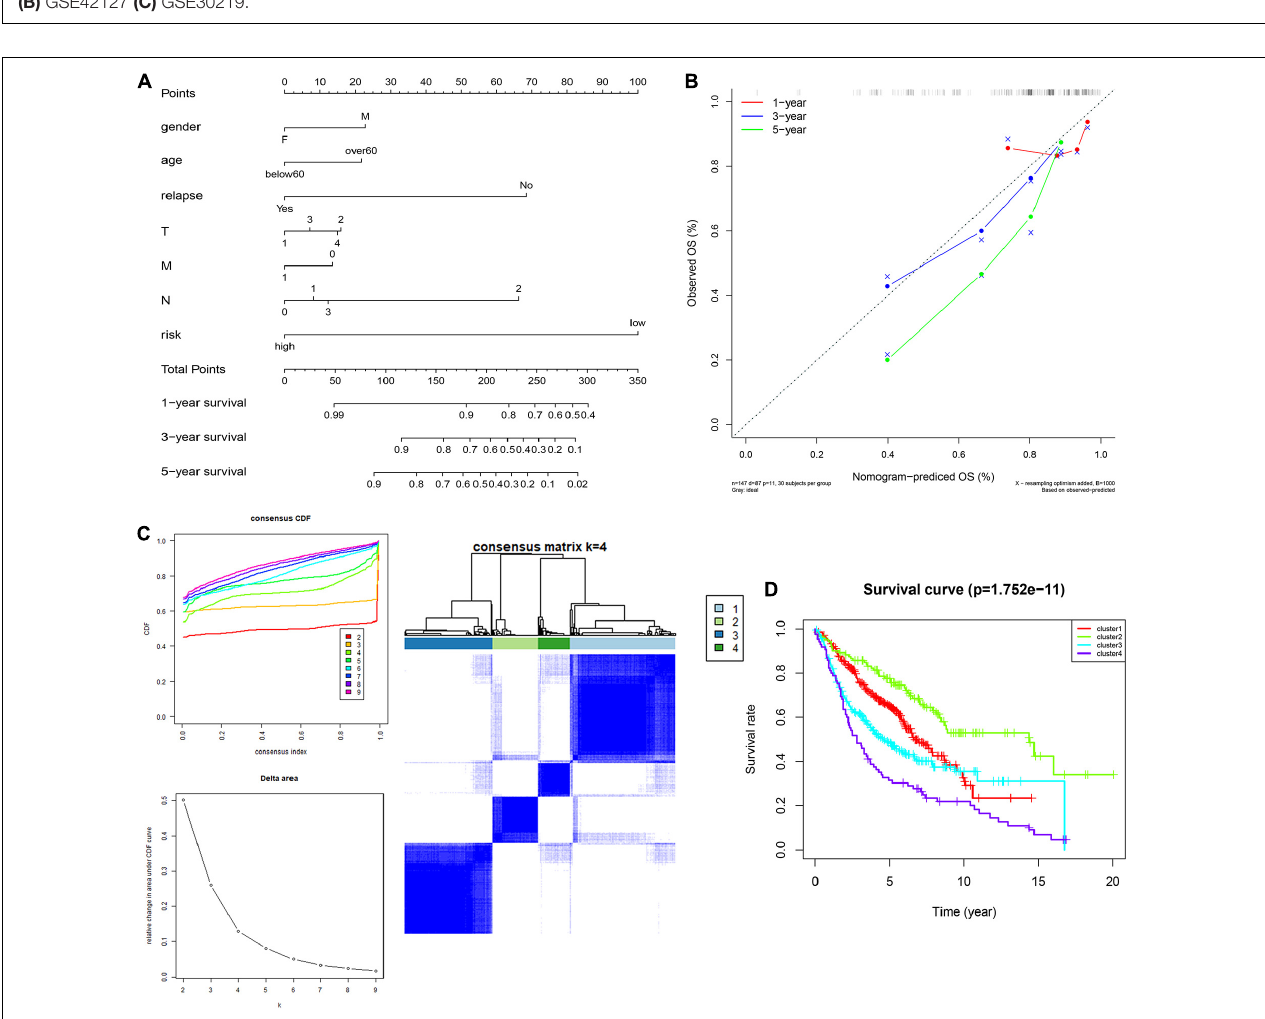
FIGURE 6 | Construction and validation of the nomogram. (A) Details of the nomogram, (B) Calibration analysis based on the nomogram. (C) Molecular subgrouping based on 10 CCRGs: Elbow and gap plot for different numbers of subgroups; Consensus heatmap of the clusters. (D) Survival analysis of the four subgroups.